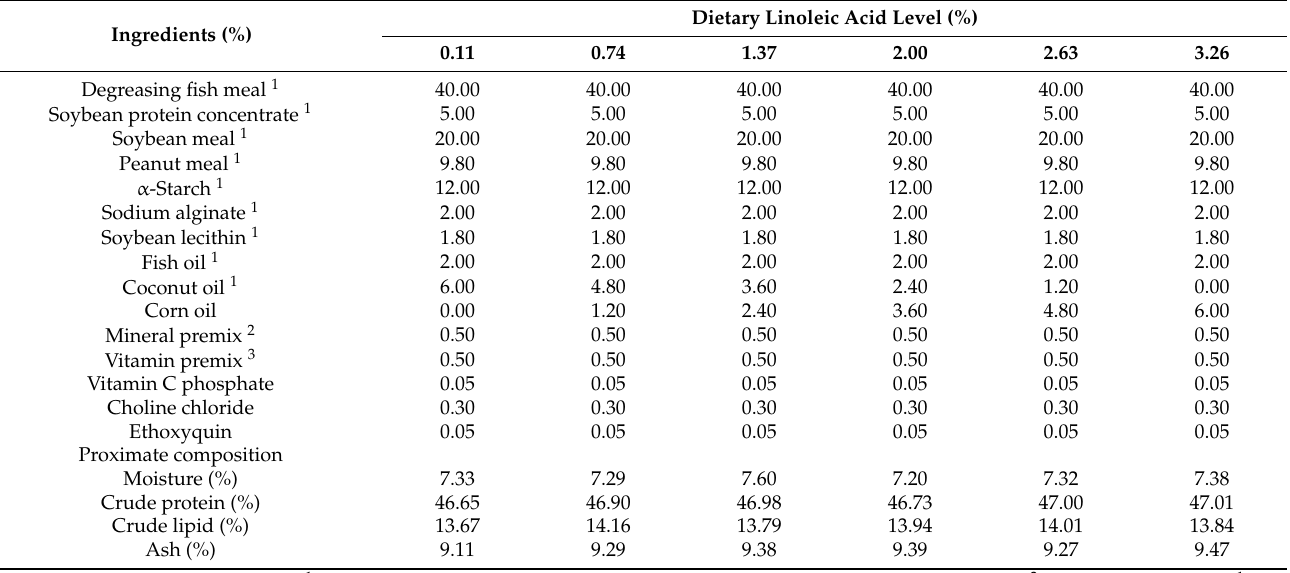
Table 1. Formulation and proximate composition of experimental diets for coho salmon Oncorhynchus kisutch alevins (% in dry matter).